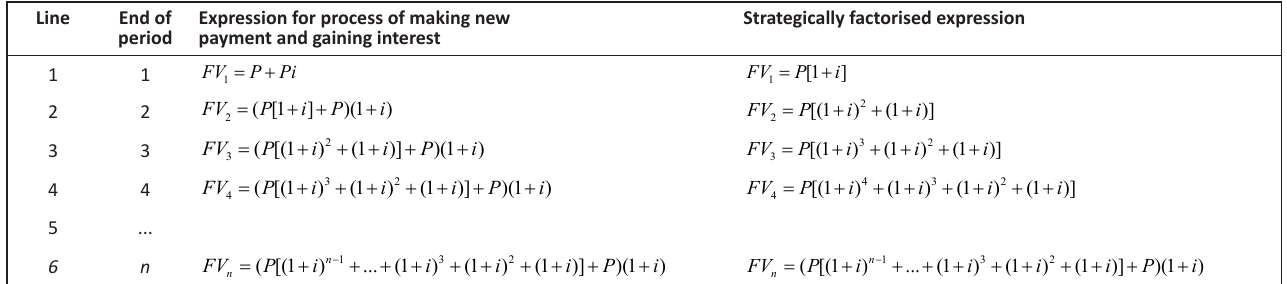
FIGURE 2: Account balance approach to generate series for future value of annuity